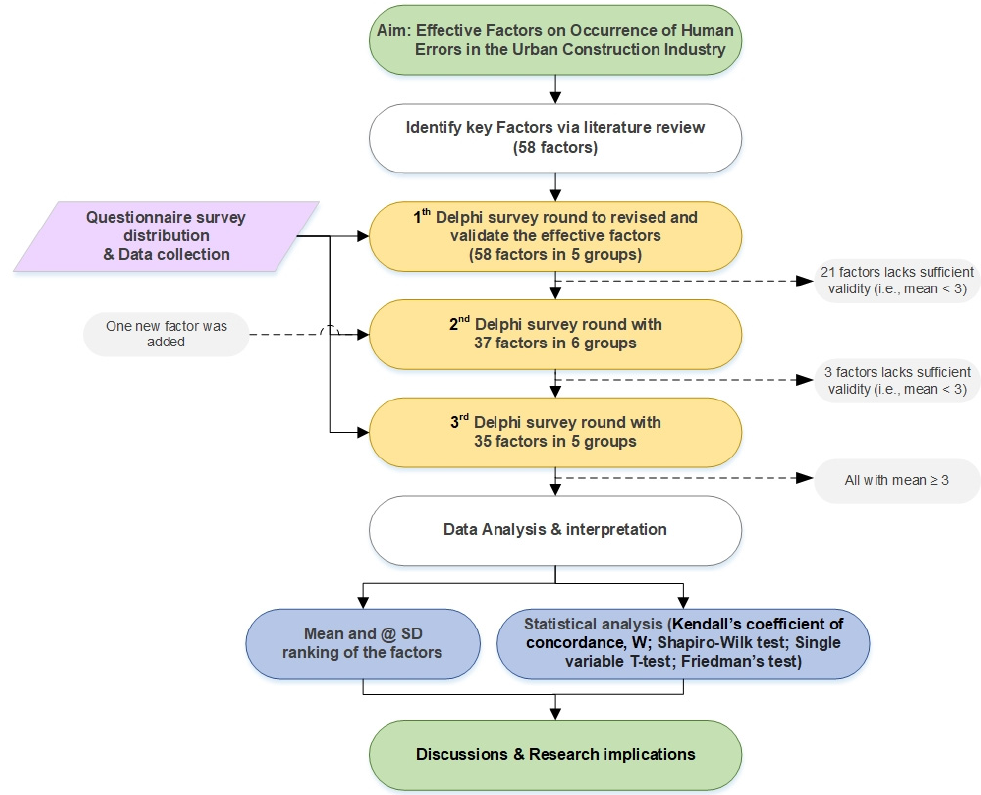
Figure 1. The overall research design for the study.